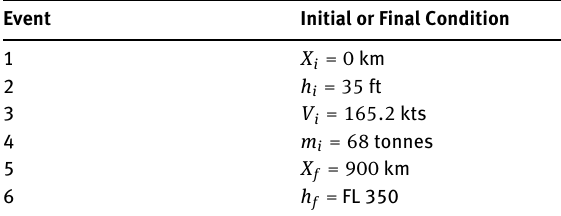
the total area of the lifting surfaces on the aircraft, ρ is the air density at a particular value of h assuming standard atmospheric conditions and f is the rate of fuel consump- tion. Finally, g is the gravitational acceleration assumed to be constant. The initial and final conditions of the air- craft, formulated as event constraints in the BOOCP prob- lem are defined in Table 1. Representative path constraints were applied to the trajectory optimisation problem to re- produce realistic limits on the performance of the aircraft and its propulsion system. The first path constraint is the stall speed of the aircraft which is a function of the aircraft configuration and constitutes the minimum value for the airspeed. The upper end of the speed scale is limited by V MO and M MO which are the maximum operating speed and the maximum operating Mach number respectively. Finally, the maximum thrust provided by the engines is also formulated as a path constraint. Table 1: BOOCP event